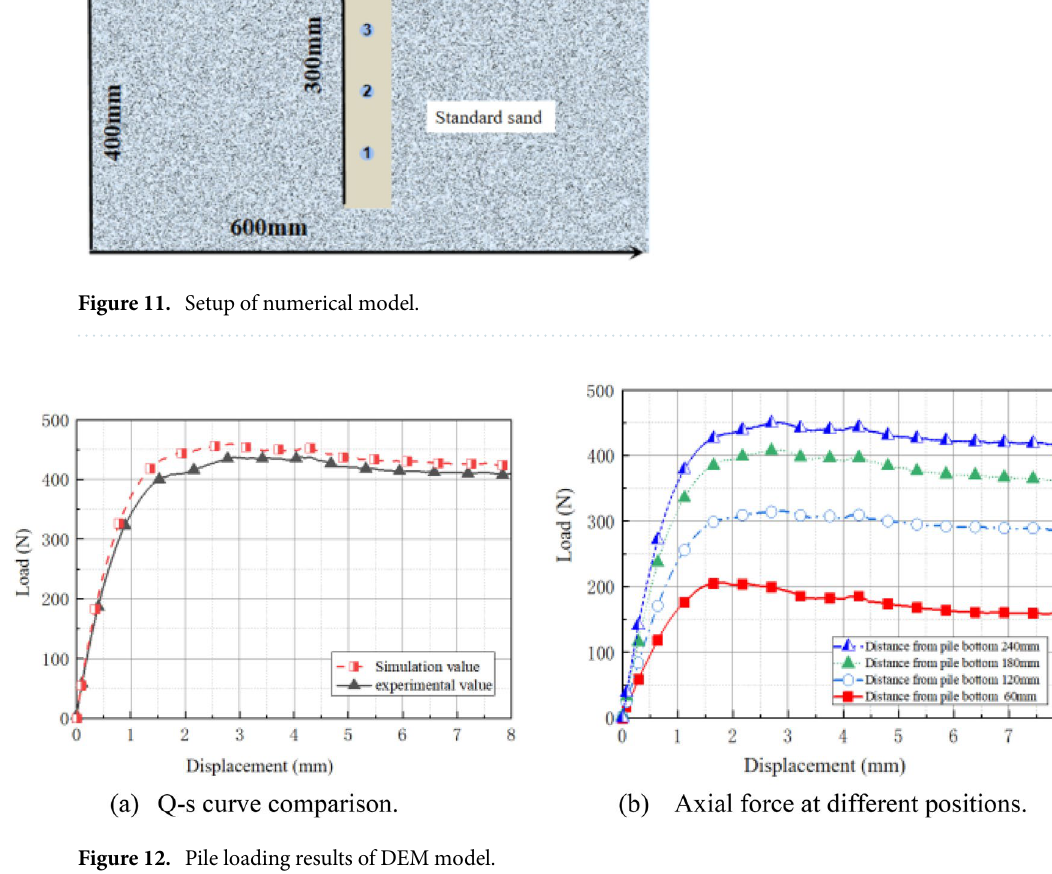
Figure 12. Pile loading results of DEM model.